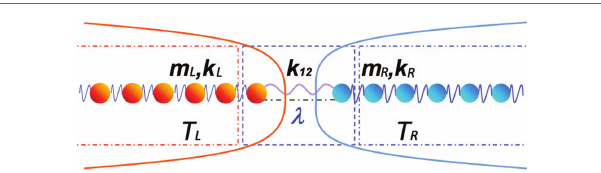
FIGURE 6 | Schematic of the one-dimensional atomic junction model for a solid–solid interface, adapted with permission from the copyright holder (Europhysics Letters), Zhang et al.